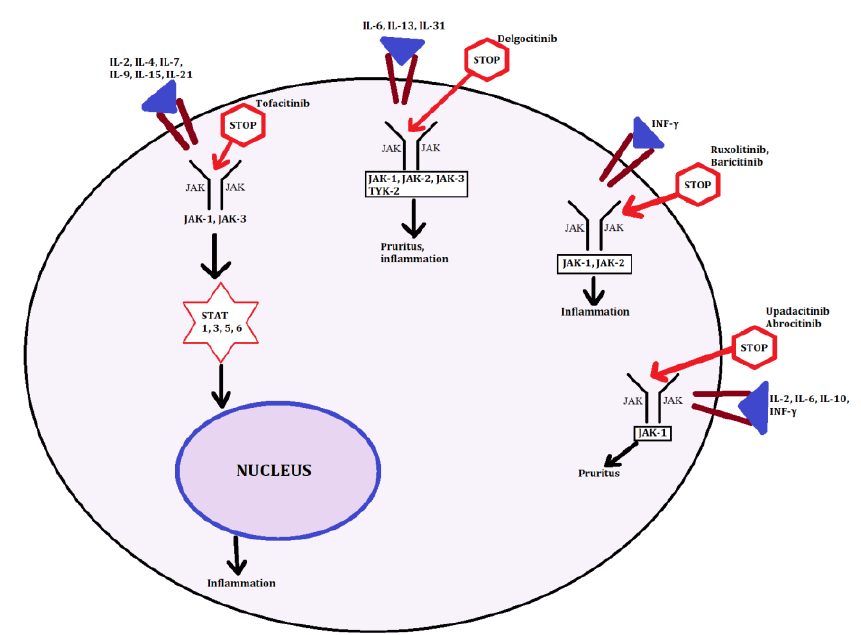
Figure 4. JAK-STAT targeting sites. In the figure, we present grip points followed by the particular JAK-STAT pathway for major inhibitors described in the article.